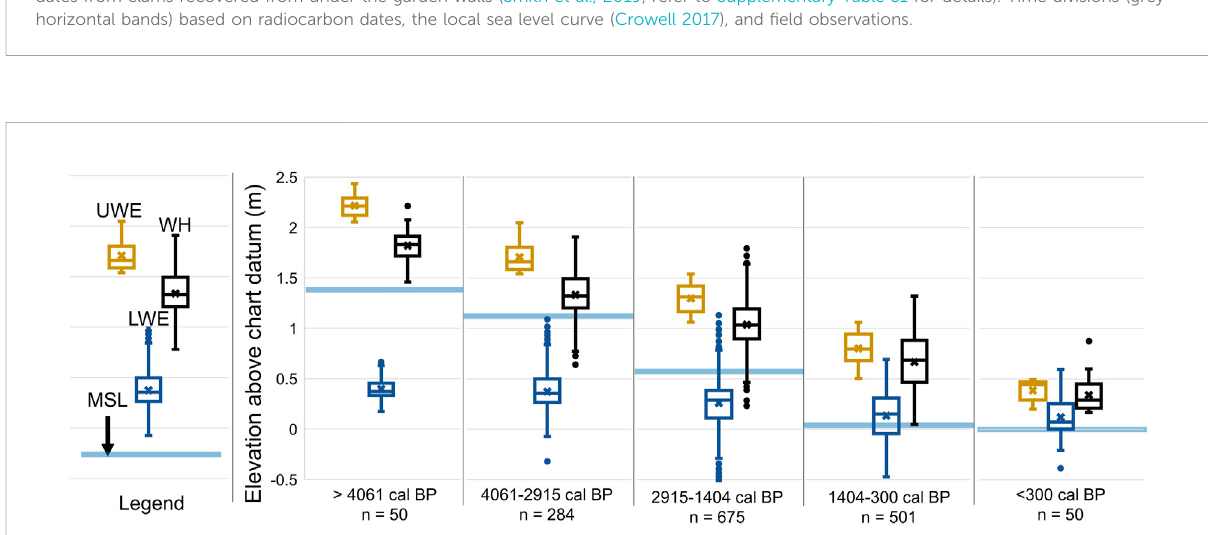
FIGURE 8 Average of top and bottom wall elevations and average wall height in relationship to median sea level per time range showing that clam garden terraces were well within productive clam garden zones. . MSL = Median sea level (horizontal blue lines), UWE = Upper wall elevation, LWE = Lower wall elevation, WH = Wall height.